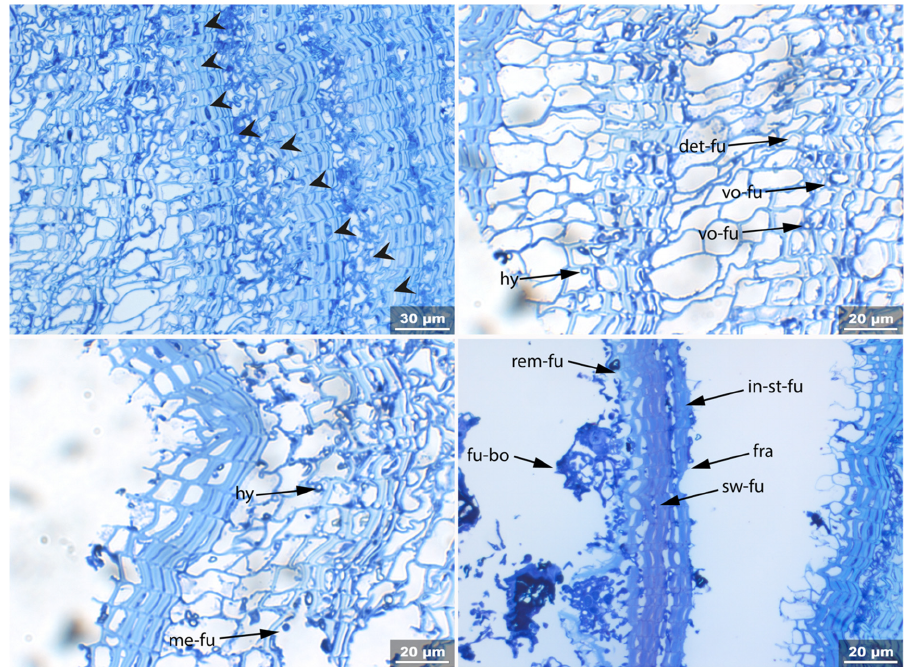
Figure 14. Sample 0. LM overview of sample with clear boundary between well-preserved area and fungal degraded area (arrowheads). Secondary walls of thick-walled cells are penetrated mainly in the corners by hyphae (vo-fu), and hyphae